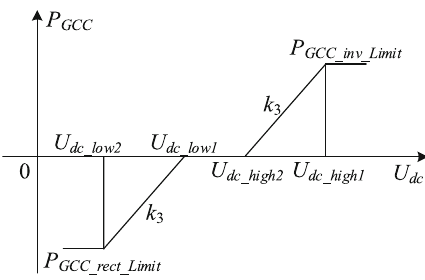
Fig. 6 Droop control characteristic curve of GCC